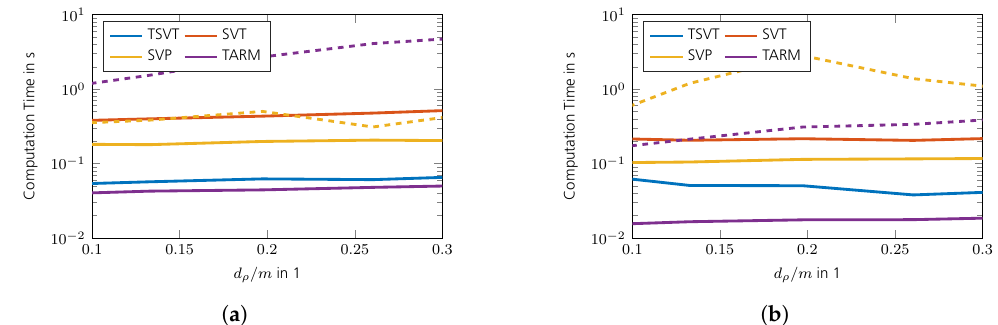
Figure 12. Comparison of computation time for m / n = 0.8 in an interval where all algorithms perform equally well. The solid lines show SVP and TARM for R = ρ and the dashed lines for R = 2 ρ . ( a ) Random sensing operators A ∼ CN ( 0,1 ) . ( b ) DFT sensing operators with random rows.